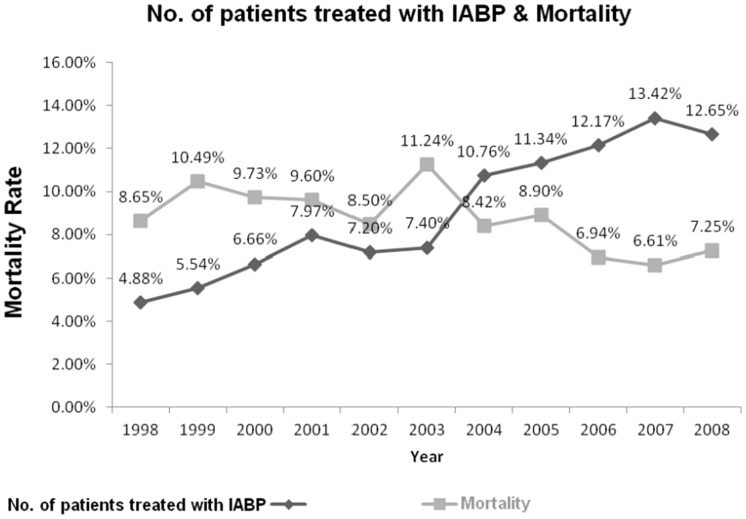
Trends of intra-aortic balloon pumping and in-hospital all-cause mortality, 1998 to 2008.Abbreviation: IABP, intra-aortic balloon pumping. The mortality rate was calculated by dividing [the number of patients treated with IABP who died in a particular year] by [the total number of patients treated with IABP in that particular year]. * p = trends over time: the number of patients treated with intra-aortic balloon pumping (IABP), p < 0.0001; in-hospital all-cause mortality, p = 0.0243.